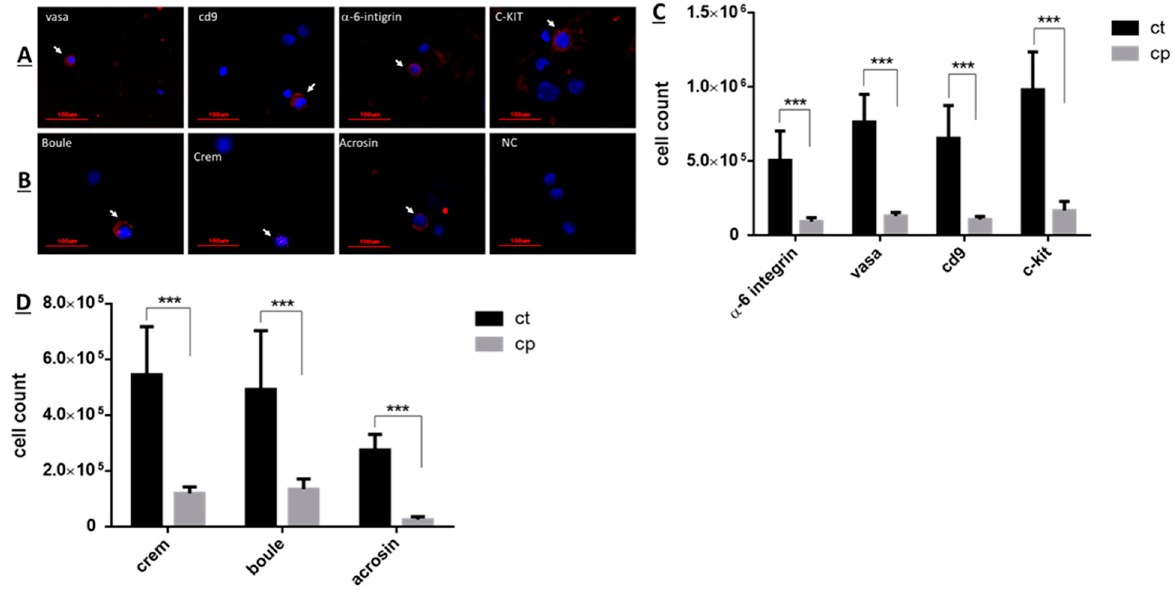
Figure 2. CP-treated immature mice showed a significant decrease in the number of subpopulations of spermatogenic cells compared to control: Cyclophosphamide (CP)- or PBS-treated mice (control, CT) were i.p injected as described in Figure 1. Ten days post-treatment, testes were removed, seminiferous tubules were separated, and cells were enzymatically isolated from the seminiferous tubules. The premeiotic cells that express α -6-INTEGRIN, VASA, CD9, GFR- α , and c-KIT, or the meiotic cells that express the markers BOULE and CREM and the meiotic/post-meiotic cells that express the marker ACROSIN were identified by immunofluorescence staining using specific primary antibodies for each cell marker and the secondary antibody Cy3 (red color). DAPI (blue color) stained the nucleus of the cells (( A , B ), respectively). The identified premeiotic, meiotic, and meiotic/post-meiotic cells were counted, and their number/testis was evaluated (( C , D ), respectively). Arrows indicate the stained cells. ***— p < 0.001.